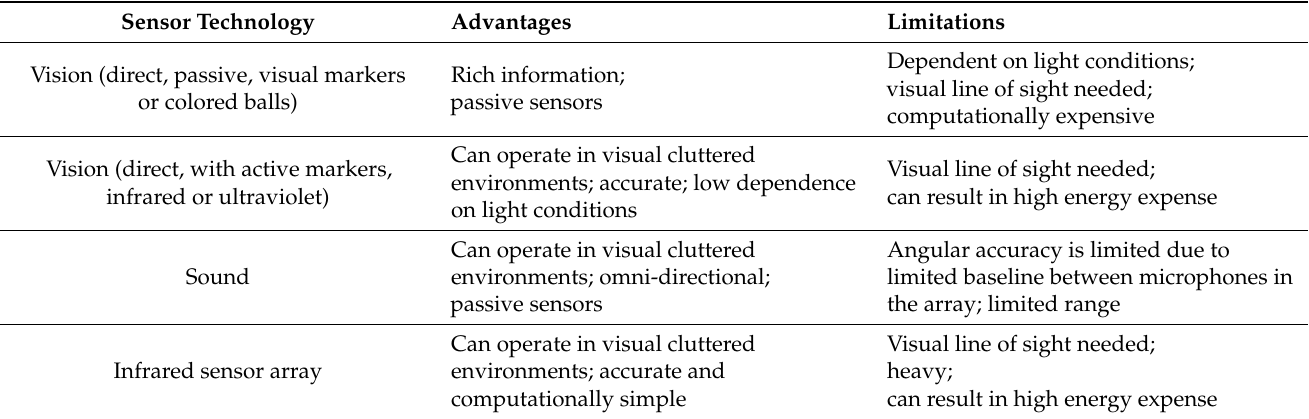
Table 9. Some technologies for MAV relative localization